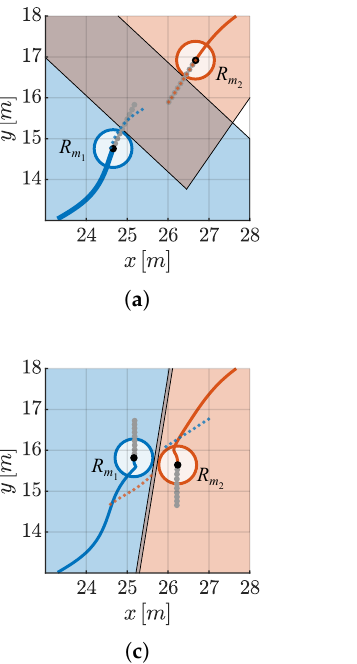
and R m . For each robot, 2 1 and R m are shown in blue and red, 2 1